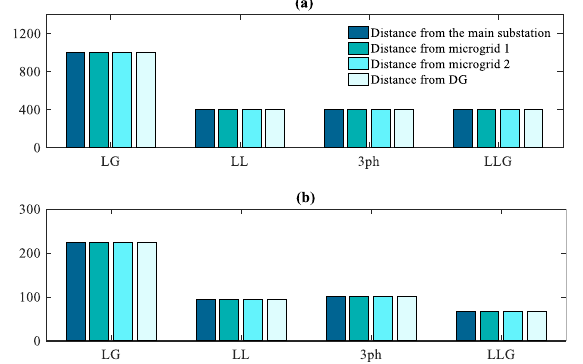
Fig. 11 Output errors of the KNN for different fault types using non-synchronized measurements for 424 test cases. a MAE b RMSE